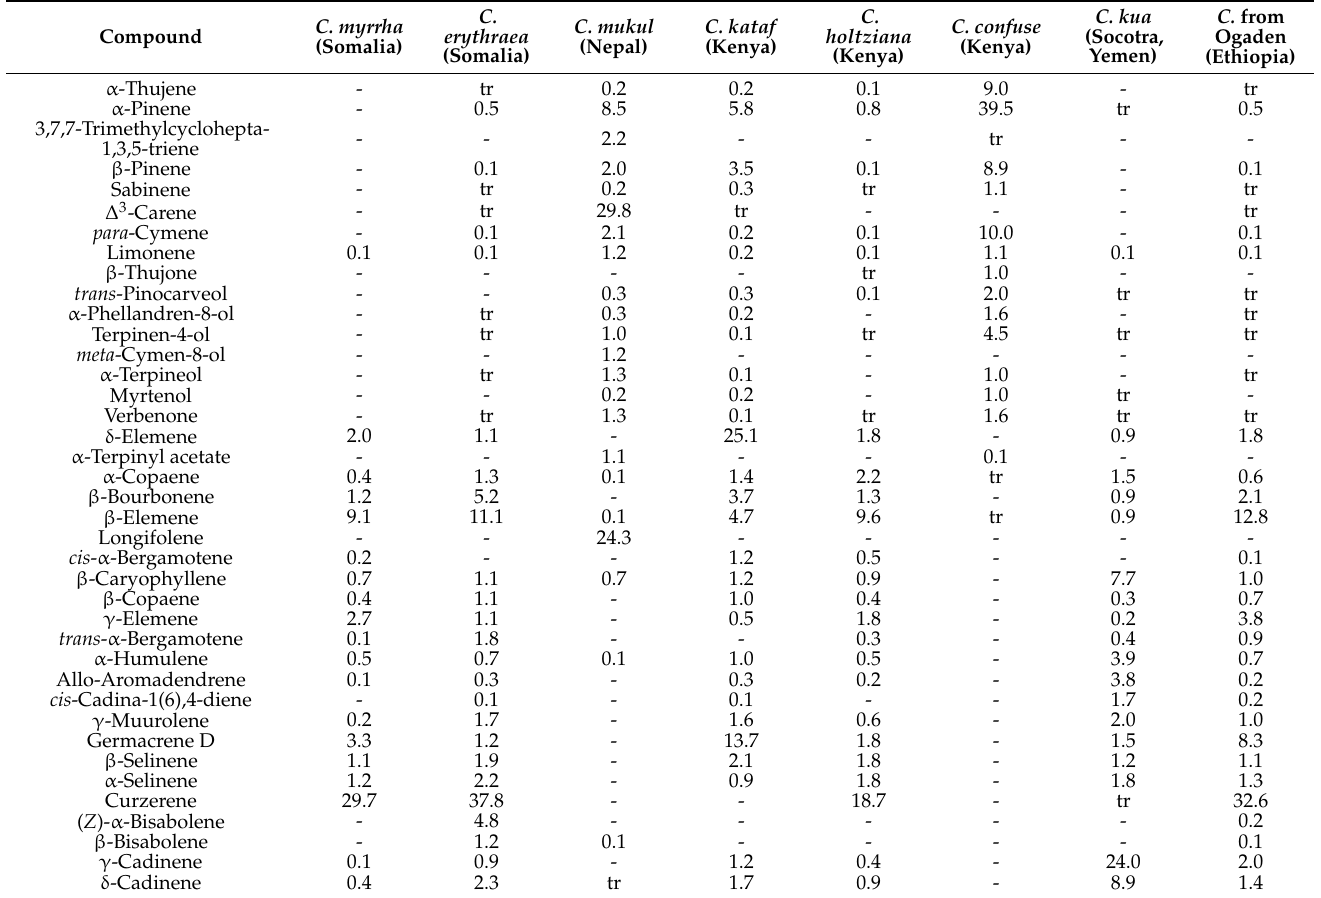
Table 4. Chemical composition of Commiphora oleogum resin essential oils. Relative quantification by gas chromatography and flame ionization detection (GC-FID) using internal normalization, areas in uncorrected %. List of main components (area > 1%). Hydrodistillation of Commiphora oleogum resin from Tarraxo (Somalia) yielded no essential oil and consequently, no GC analysis is shown. Traces tr < 0.05%. Complete data are shown in Supplementary Materials, Table